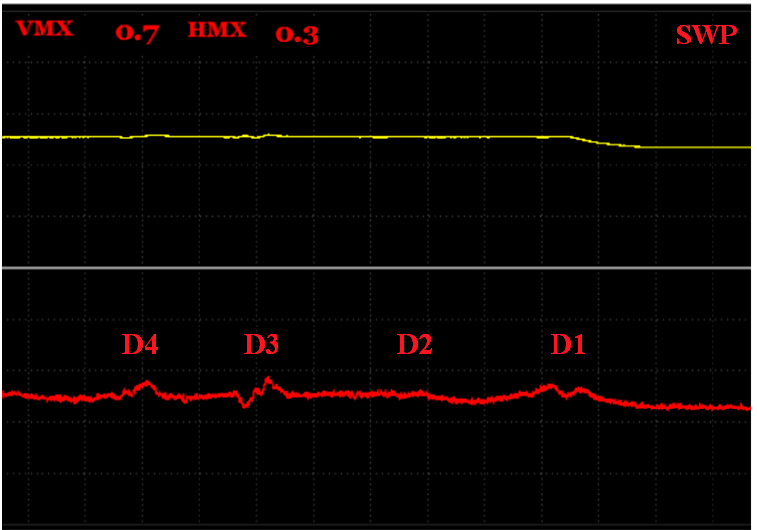
Figure 16. S4 sample, signal-to-depth of defect variation at 15 kHz excitation frequency.